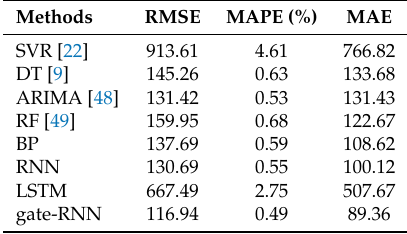
Table 3. Results of eight methods on the 5-min time scale in a three months’ test dataset.